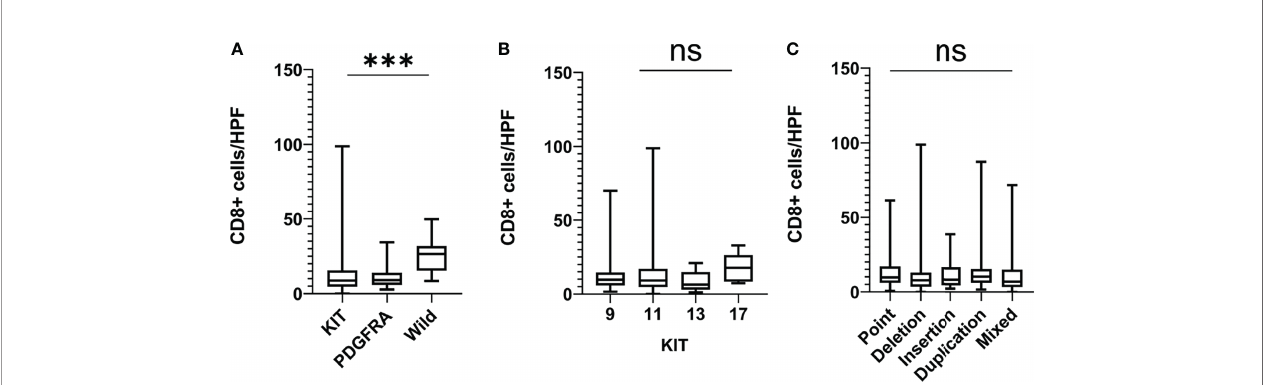
FIGURE 2 | The number of CD8+ T cells in different gene mutation types of GISTs. (A) Wild-type mutated GISTs were enriched with CD8+ T cells as compared with KIT and PDGFRA mutated GISTs; (B, C) There was no signi fi cant difference in CD8+ T cell in fi ltration between the point mutation type, deletion mutation, insertion mutation, repeat mutation, and mixed mutation types or between the KIT exon 9, 11, 13, and 17 mutations. HPF, high-power fi eld; ***P < 0.001; ns, no signi fi